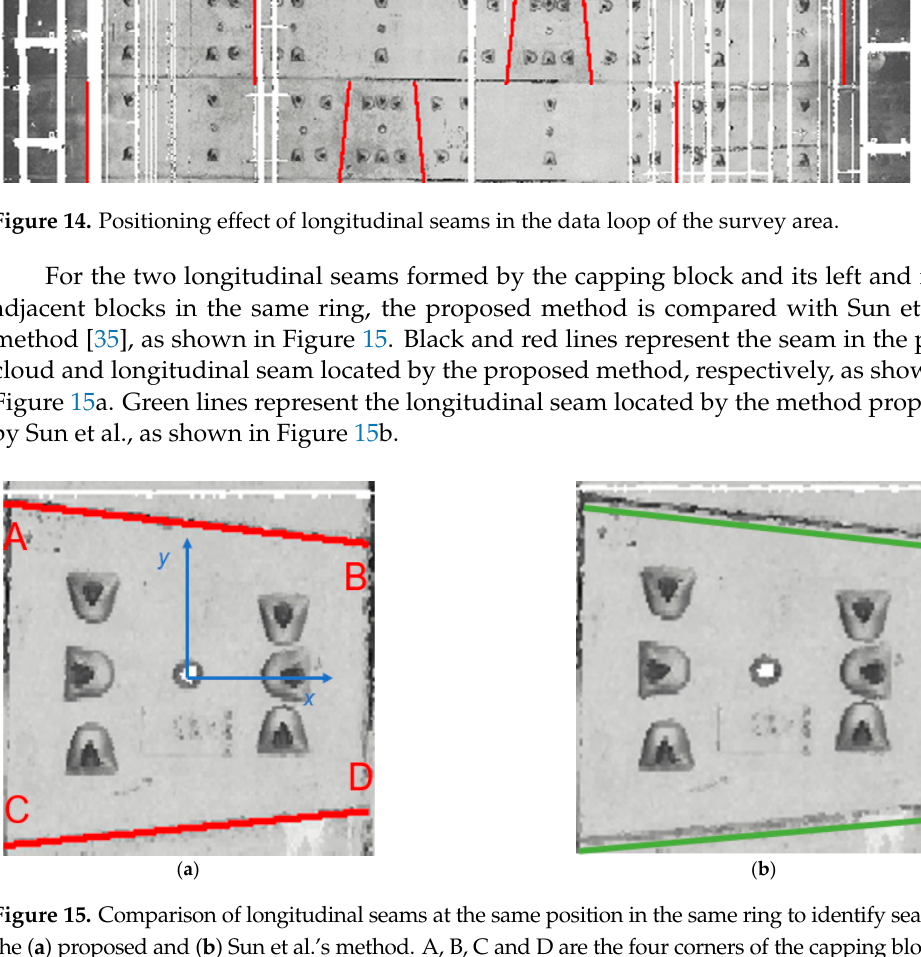
Table 3. Comparison between the original cloud seams and proposed method.